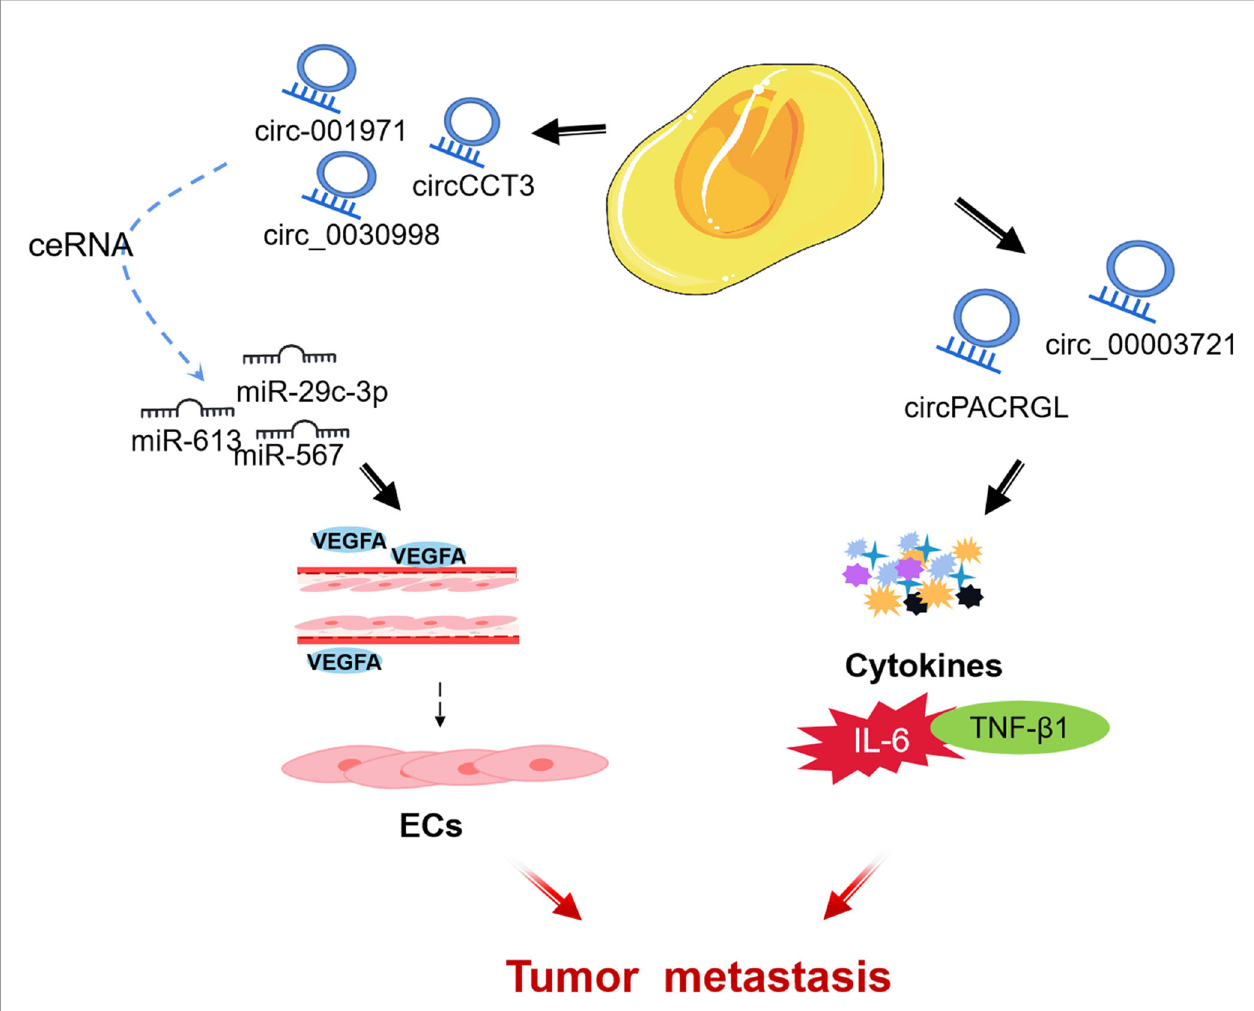
FIGURE 4 | circRNAs regulates TME of